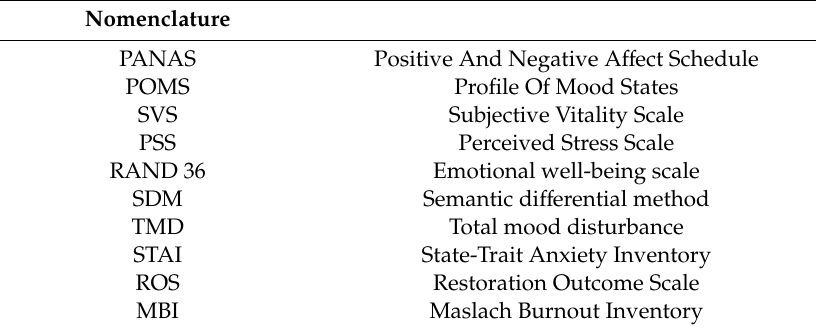
Table 1. Acronym of self-rated indicators used in primary studies.